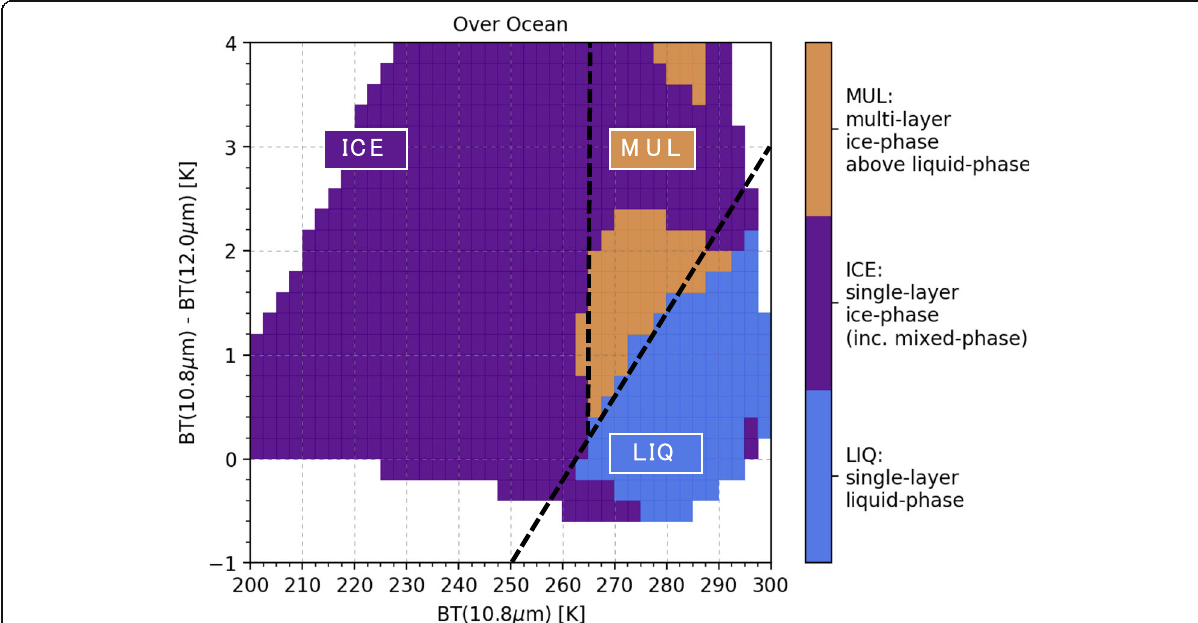
Fig. 5 The most frequent cloud phases as a function of the brightness temperature (Tb) of the 10.8- μ m channel and the difference between the brightness temperatures of the 10.8- and 12- μ m channels extracted by a combined use of CloudSat CLDCLASS-LIDAR and MODIS-AUX products. The color represents most frequent cloud phases: the cloud-phase flag is set to “ ICE ” if Tb (10.8 μ m) – Tb (12.0 μ m) > 0.08 Tb (10.8 μ m) – 21 and Tb (10.8 μ m) < 265 K, whereas this flag is set to “ LIQ ” if Tb (10.8 μ m) − Tb (12.0 μ m) < 0.08 Tb (10.8 μ m) − 21, and the other flags are labeled as “ MUL